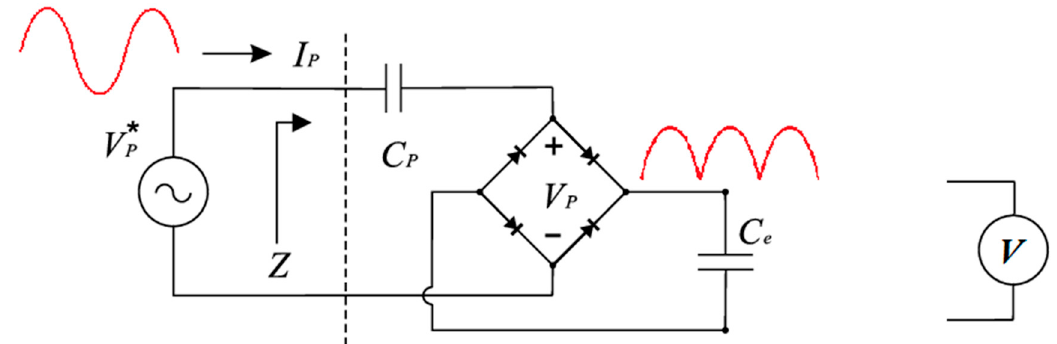
Figure 8. Energy was harvested through a rectifier into a capacitor. The harvester with a 13.75 g tip mass was measured. Energy was harvested through a rectifier into a capacitor, and the voltage was measured from the capacitor after different time periods. This harvested energy into capacitor was compared to the calculated energy from the measured voltage over an electrical load at the same rotation frequency of 4.5 Hz as in previous measurements. Two different-sized capacitors of 103.7 µF and 448 µF were used for comparison, and the voltage was measured over time. The results can be seen in Figure 9.